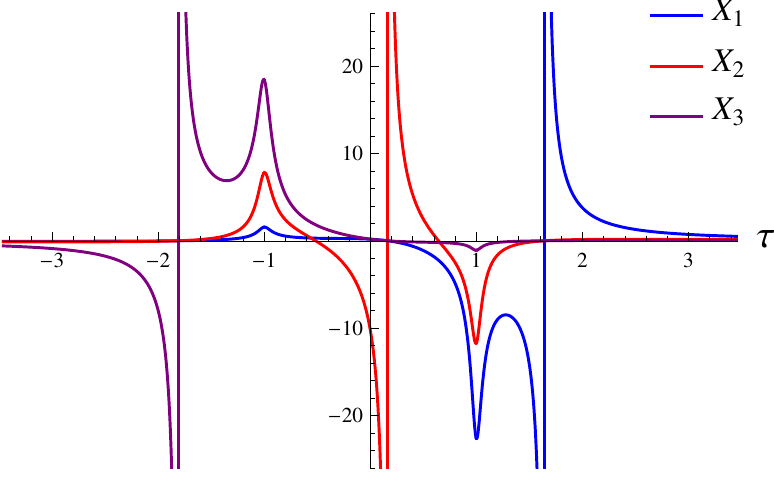
Figure 3. Behavior of the variables X i given by Equation (35) in the modified theory (11) with α Λ 0 = 5 × 10 − 3 . As in general relativity (see Figure 2), each variable X i has a pole at respective τ = τ i . However, the common poles at τ = ± 1 disappear, and the variables X i become regular at these